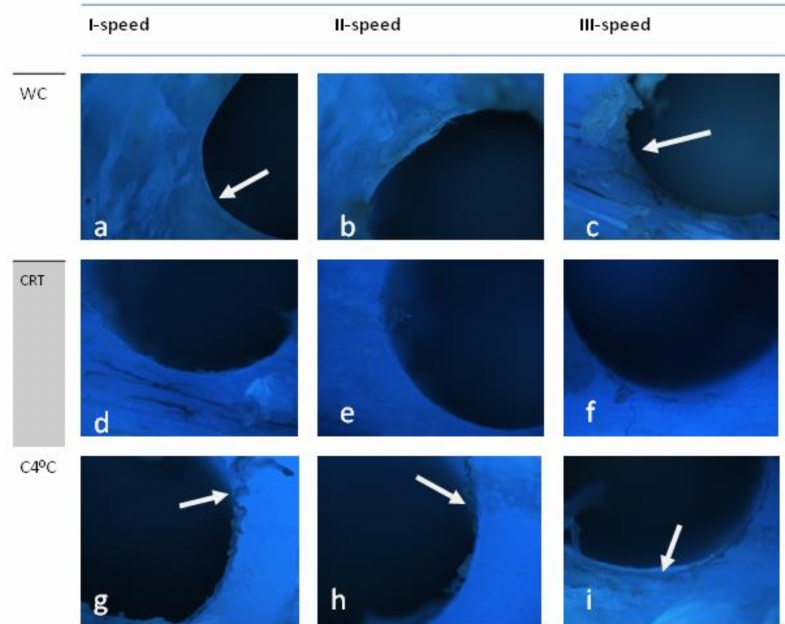
Figure 3. Drill-Straumann. The surfaces of holes drilled at different speeds (I-800 rpm, II-1000 rpm, III-1200 rpm) and using different cooling methods. Note the different smoothness and signs of carbonization(arrow). WC-without cooling, CRT-cooling at room temperature, C4 ◦ C cooling at 4 ◦ C. Autofluorescence. Mag. x40. ( a – c ) WC-without cooling, ( d – f ) CRT-cooling at room temperature, ( g – i ) C4 ◦ C cooling at 4 ◦ C.